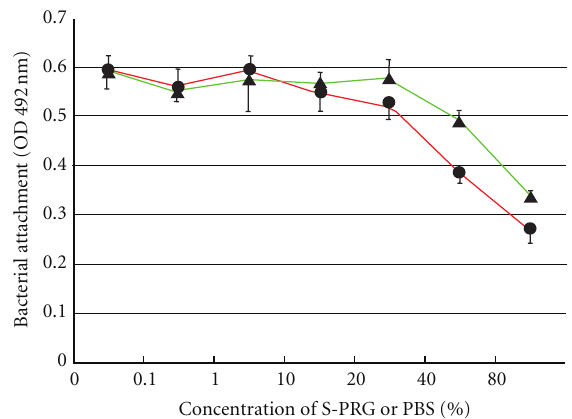
Concentration of S-PRG or PBS (%) Figure 1: Adherence of Streptococcus mutans JCM 5705 in the presence and absence of PBS or S-PRG eluate. To evaluate the e ff ect of S-PRG eluate on adherence, di ff erent percentages of S-PRG were substituted for culture medium (circle). For the control, phosphate- bu ff ered saline was used instead of S-PRG (triangle). The plates were incubated at 37 ◦ C for 16 h under anaerobic conditions, stained with 0.25% safranin, and the amount of stain in an ethanol- solubilized sample quantified by measuring absorbance at 492 nm. Data are representative of three independent experiments and the bars indicate the standard deviation.